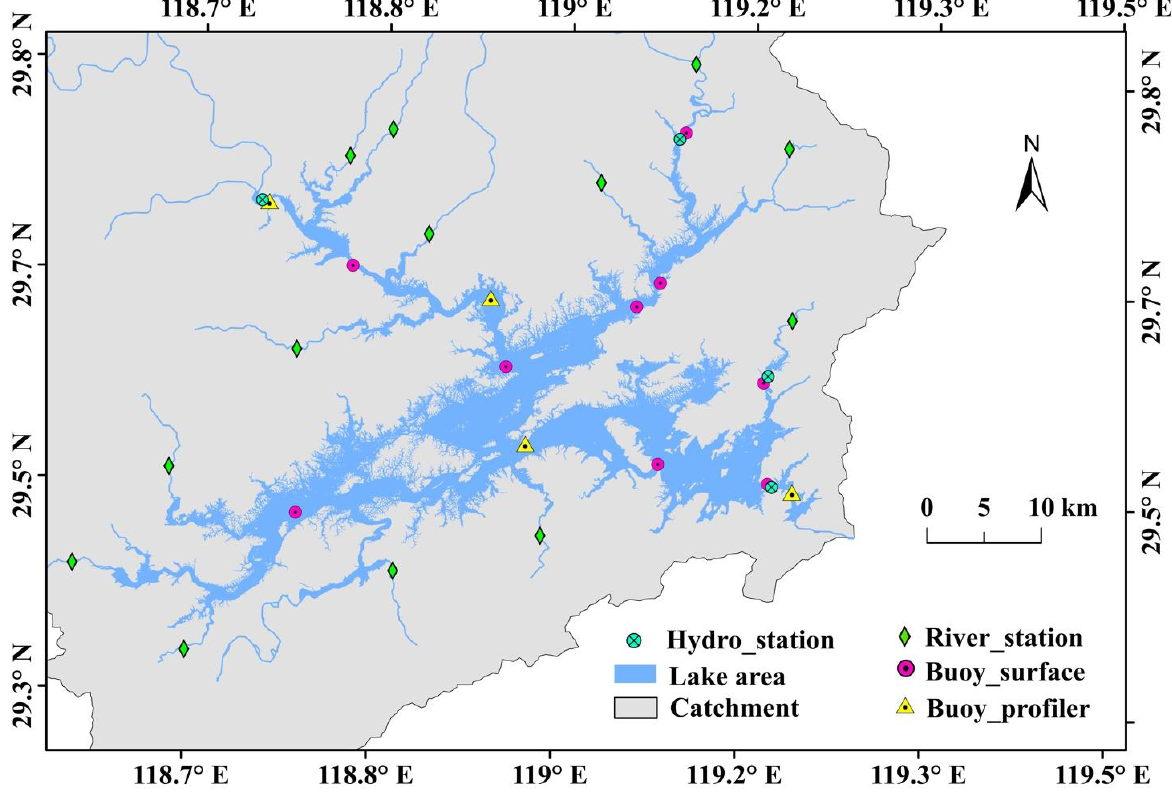
Figure 1. Monitoring sites at Lake Qiandao and its location within China.